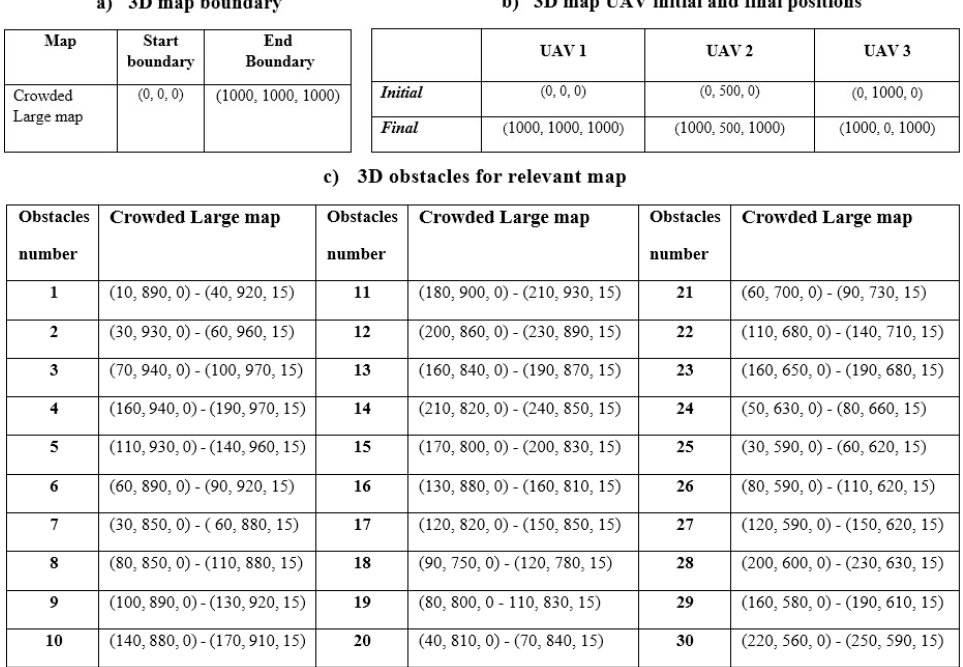
Figure 3. Land map ( a ), UAVs ’ positions ( b ) and obstacles coordinates ( c ).